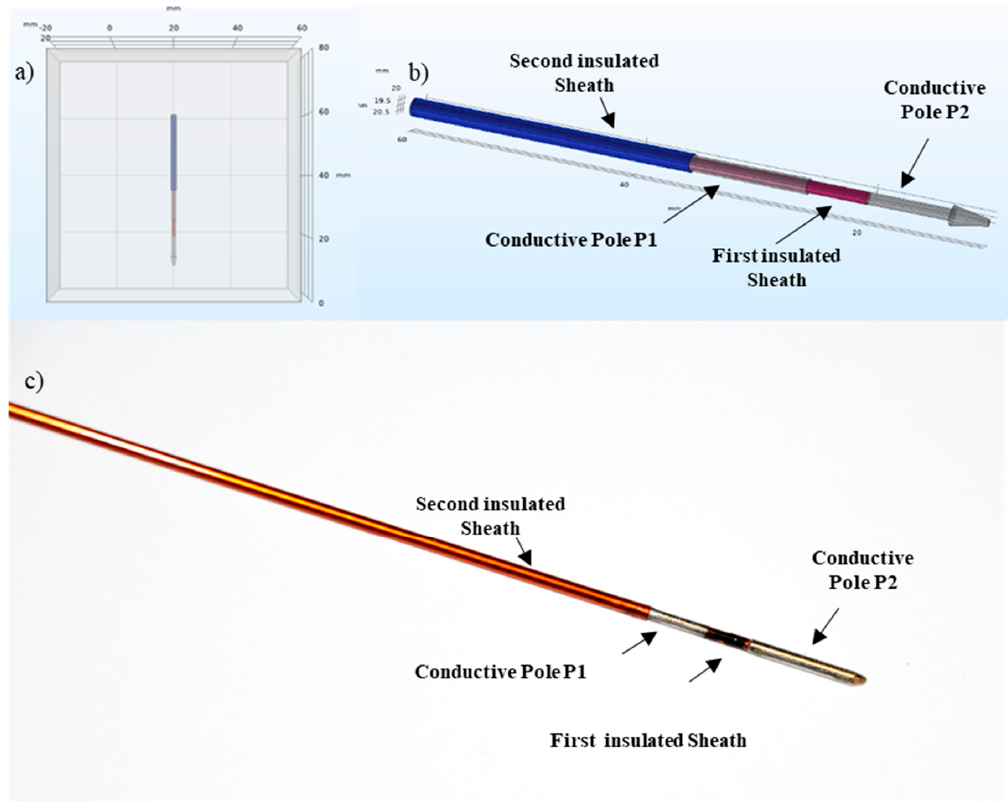
Figure 7. Bipolar coaxial electrode. ( a ) Positioning of the device inside the simulated organ (cube). ( b ) Electrode geometry implemented in Comsol Multiphysics ® : two conductive poles, a tip and two insulated sheaths. ( c ) An example of bipolar electrode prototype. Biology 2020 , 9 , x FOR PEER REVIEW